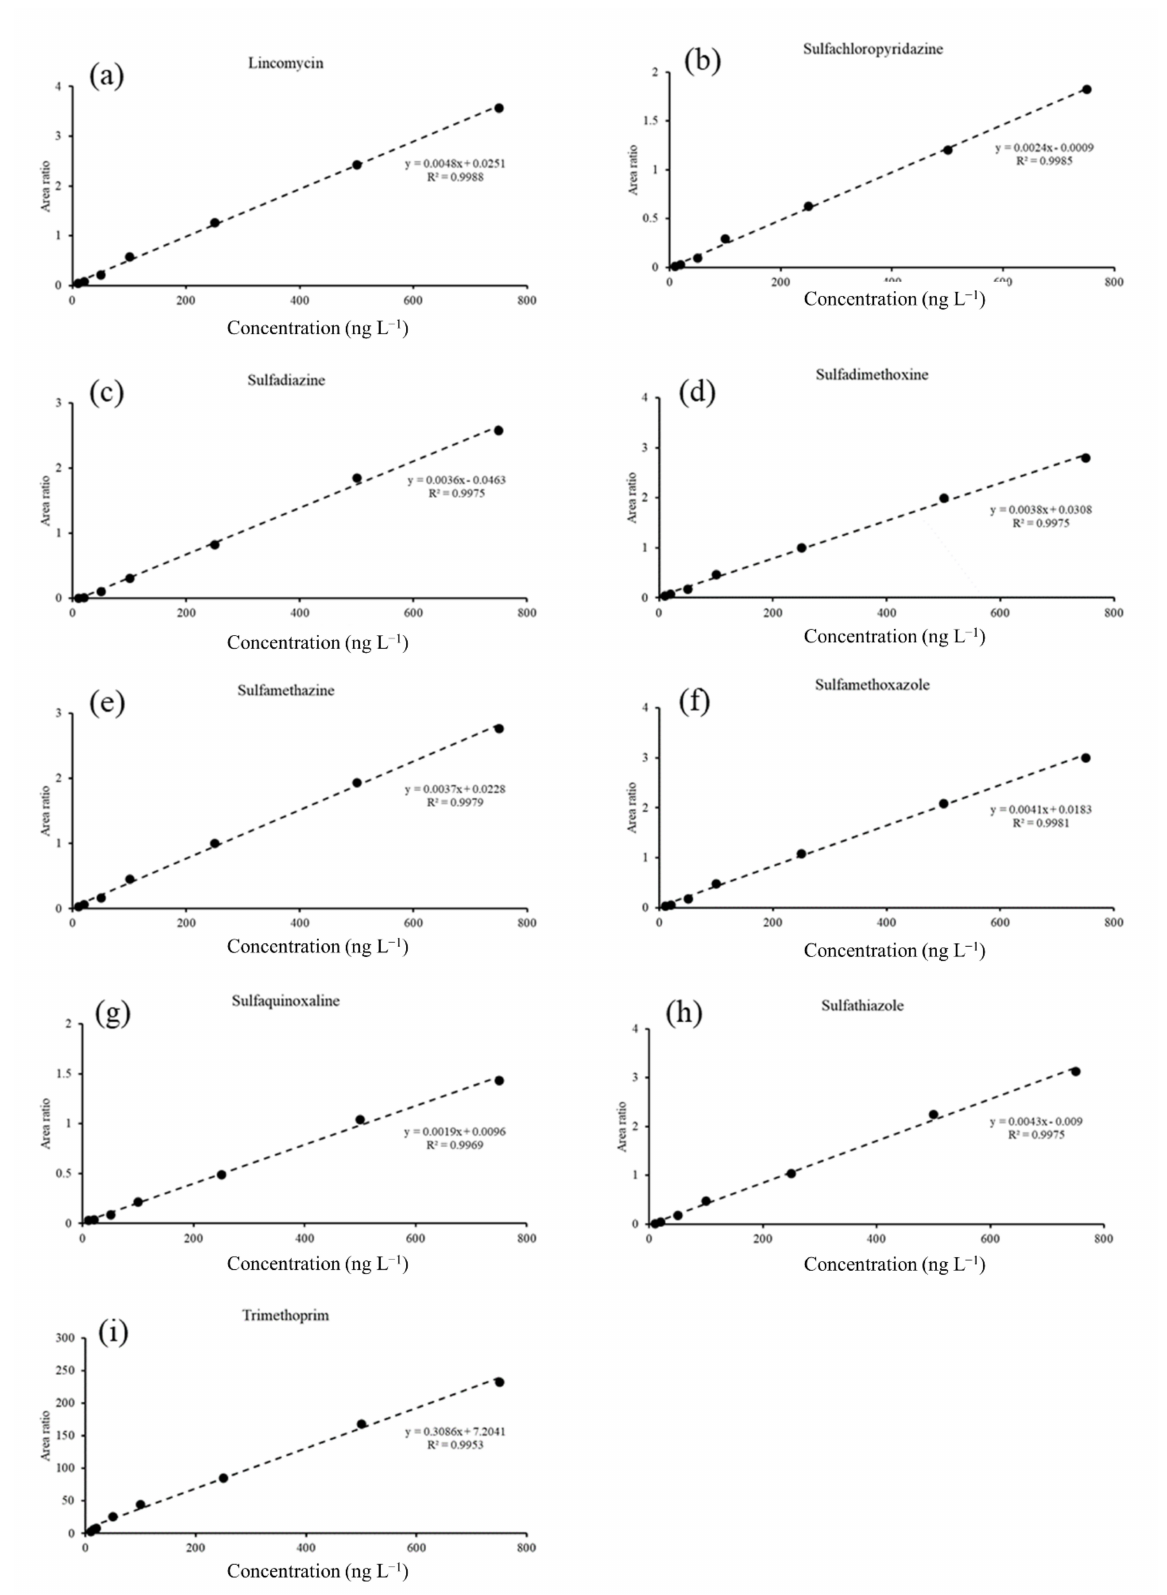
Figure A1. Calibration curves using UHPLC-q-orbitrap HRMS, combined with an online SPE analysis for the nine antibiotics analyzed. ( a ) lincomycin, ( b ) sulfachloropyridazine, ( c ) sulfadiazine, ( d ) sulfadimethoxine, ( e ) sulfamethazine, ( f ) sulfamethoxazole, ( g ) sulfaquinoxaline, ( h ) sulfathiazole, and ( i )